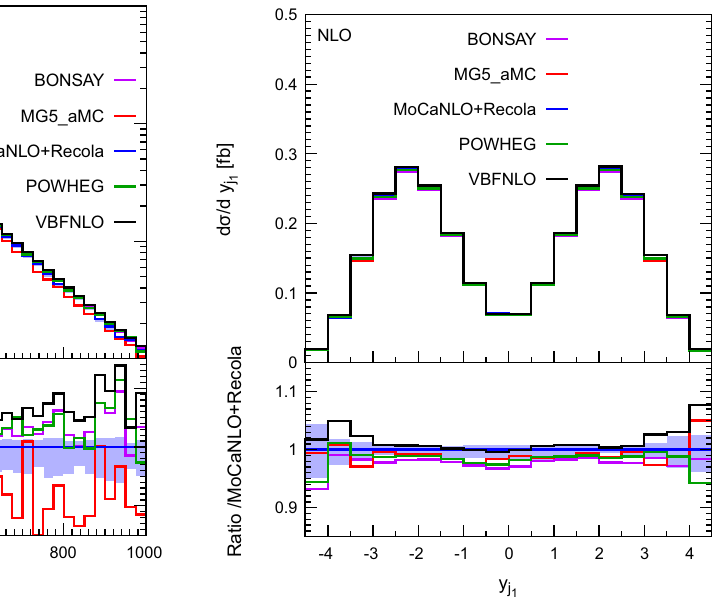
Fig. 11 Differential distributions in the transverse momentum (left) and rapidity (right) of the hardest jet at NLO accuracy i.e. at order α 6 ) . The description of the different programs used can be found O (α s in Sect. 3.2. The upper plots provide the absolute value for each pre- diction while the lower plots present all predictions normalised to